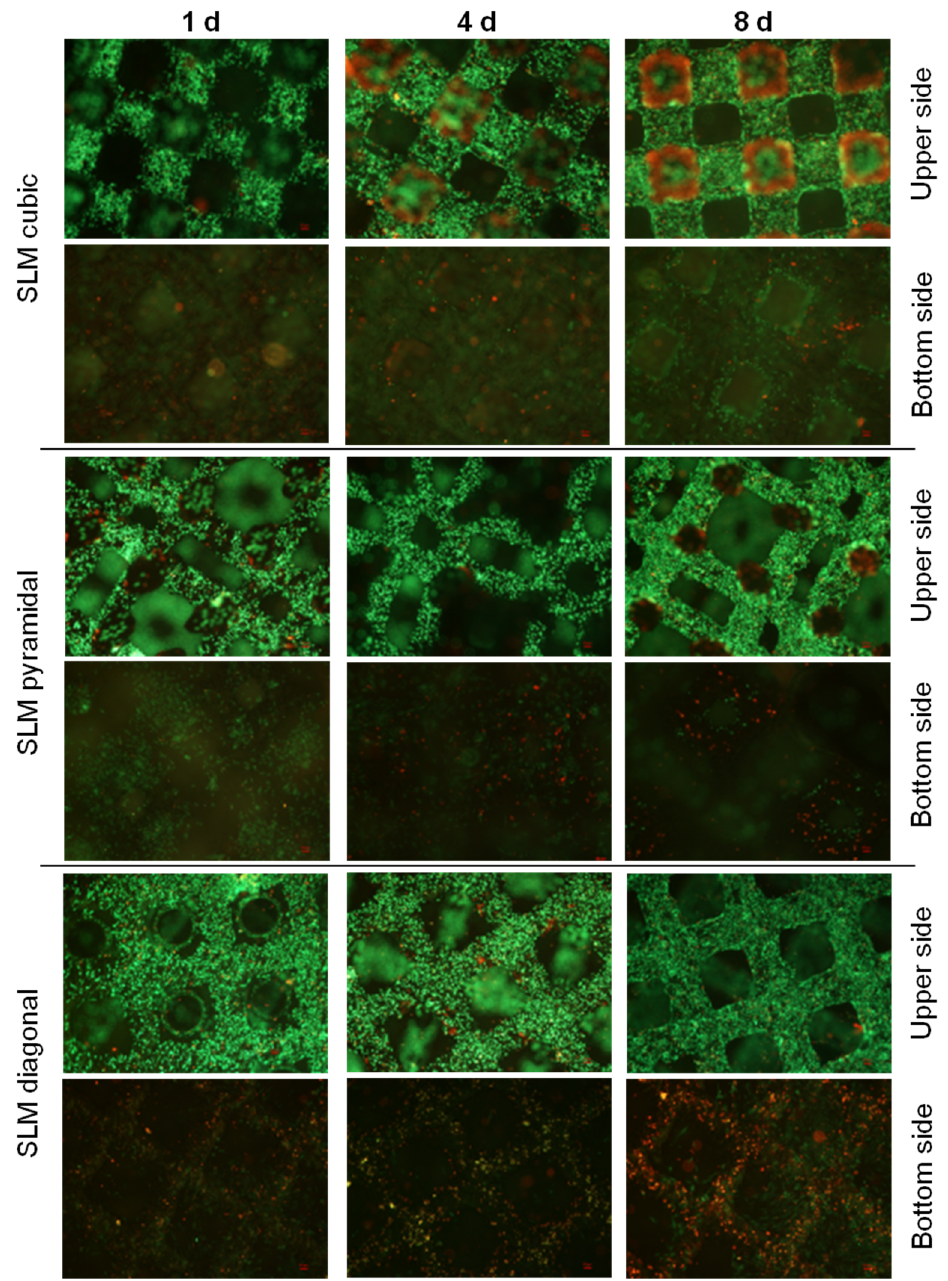
Figure 10. Live/dead staining of SLM manufactured scaffolds with several designs after static cultivation (one day, four days and eight days). Living cells are displayed in green, dead ones in red. Magnification: 40×. Scale bar: 50 µm (down right).